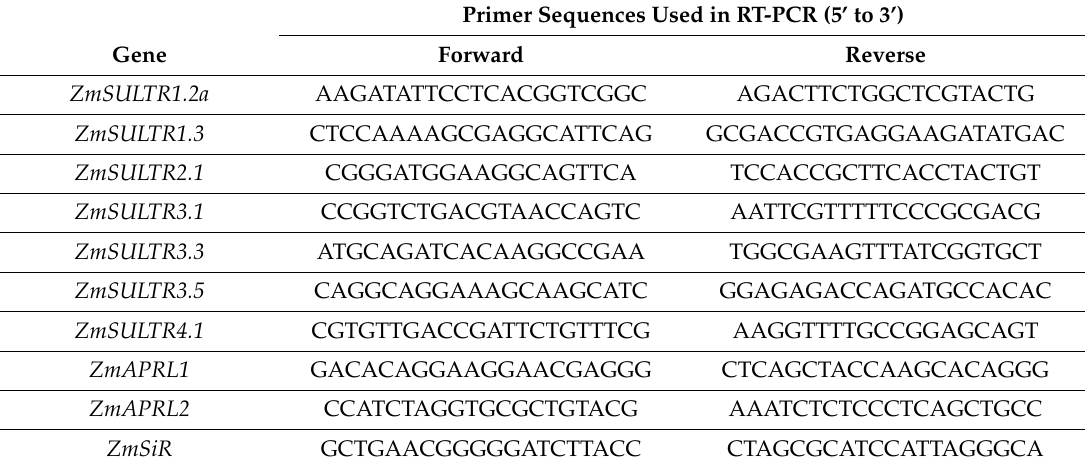
Table 3. The oligonucleotide primers used for this analysis. Primer Sequences Used in RT-PCR (5’ to